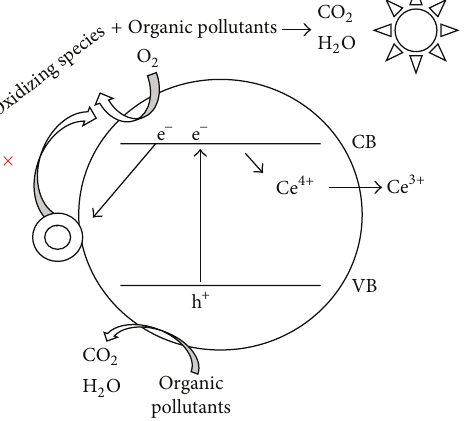
Figure 8: The proposed photocatalytic mechanism of CeO 𝑥 /TiO 2 nanoparticles for the degradation of MB under visible